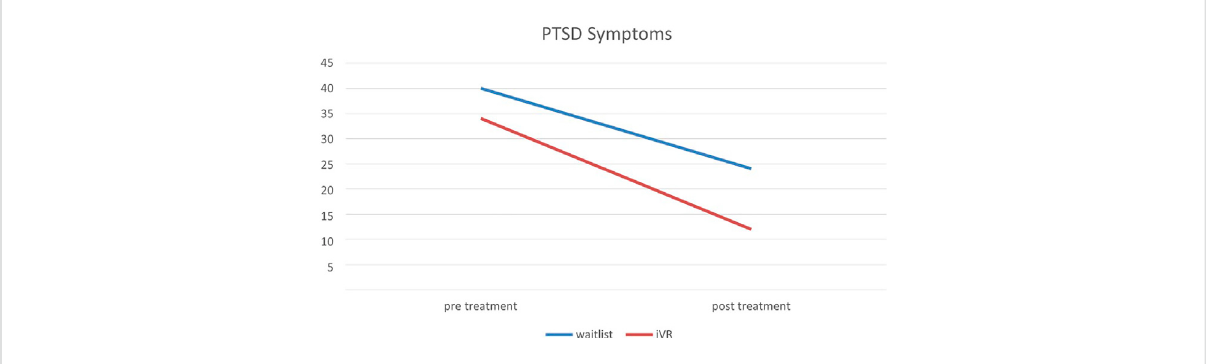
FIGURE 6 Changes in PTSD symptoms, pre and post